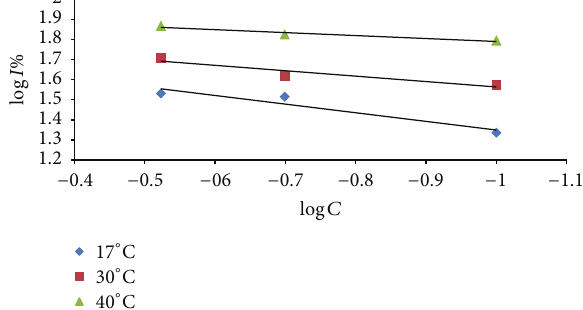
Figure 8: log 𝐼 % versus log 𝐶 for mild steel corrosion in 1MHCl for GA at 17, 30, and 40 ∘